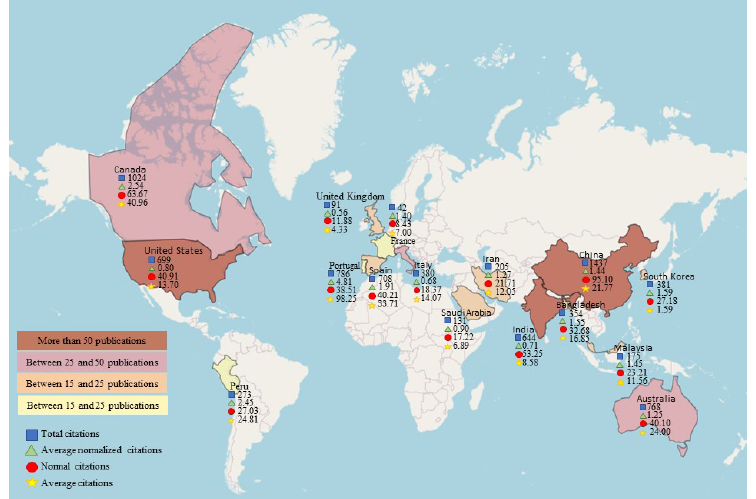
Figure 6. Countries with greater importance in the field, in terms of publication count, total citations, and average normalized